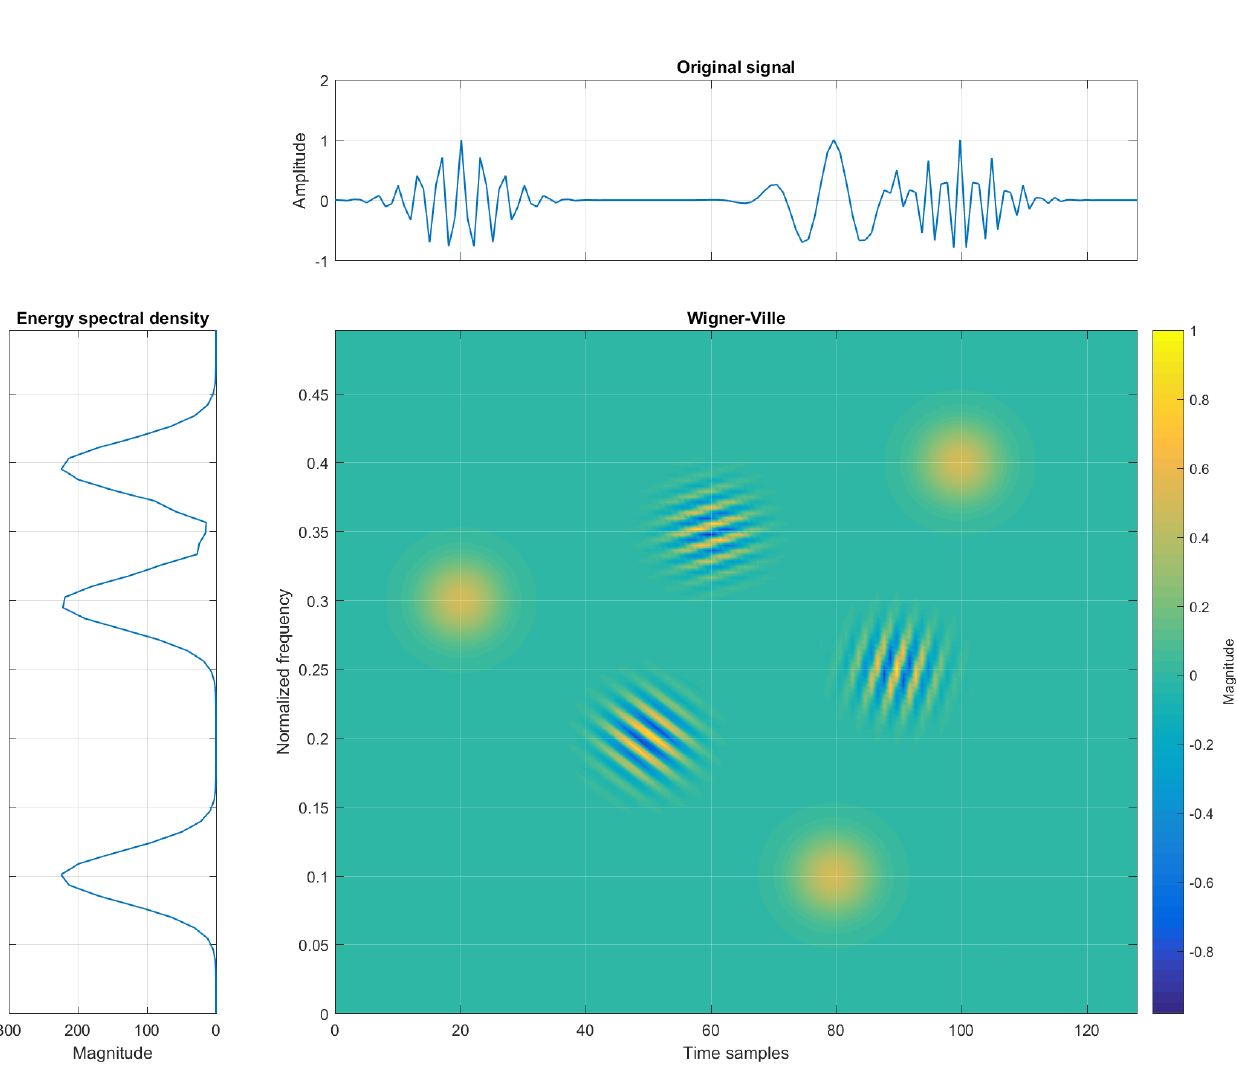
Figure 2. Example of three elementary Gaussian atoms in the time, frequency, and TF domains (Wigner-Ville) with